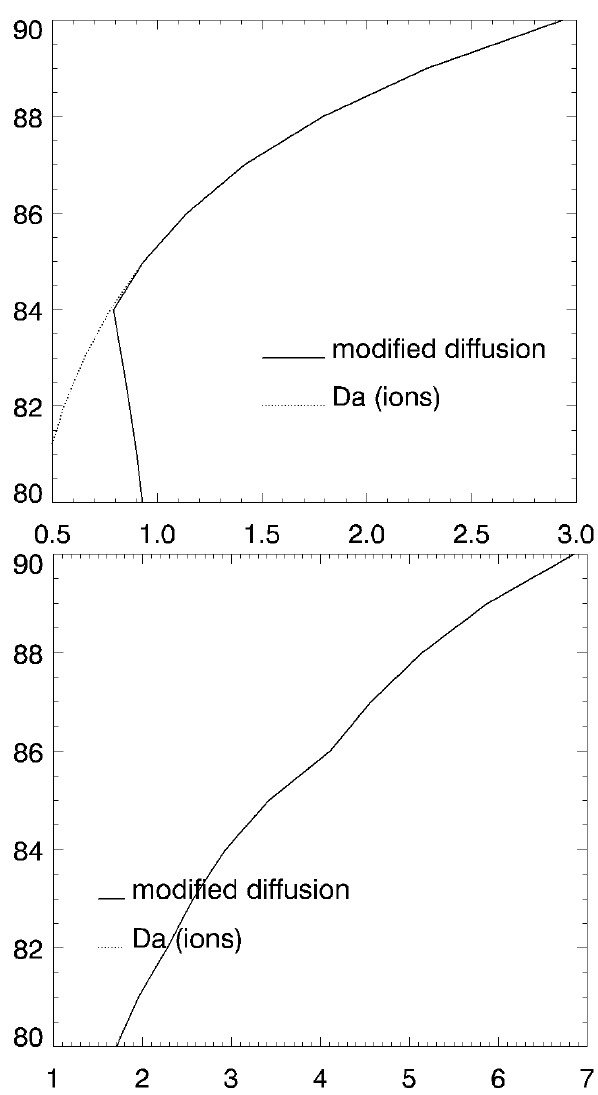
Fig. 6. Simulated profiles of ambipolar diffusion coefficient as might be estimated by a 31MHz radar situated at 80 ◦ N in which the meteor trail ions are assumed to be N + mer; note the incorrect result below 84km. Lower panel: winter; turbulence is less of a